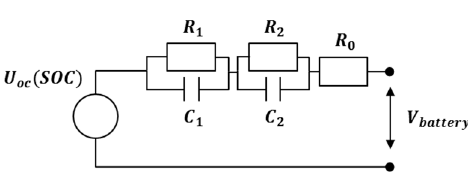
Figure 3. Chen battery model.